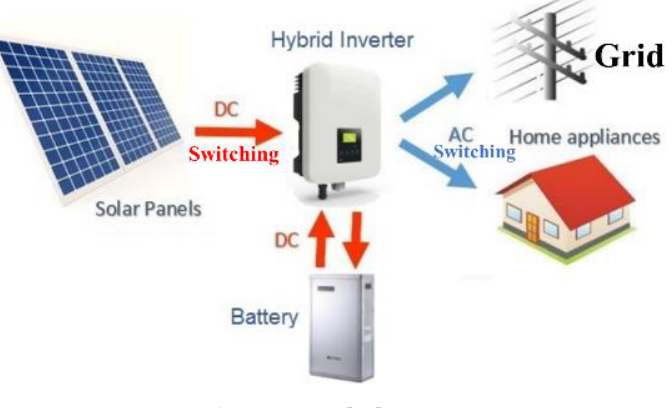
Figure 4. Inverter Based Generation [15].